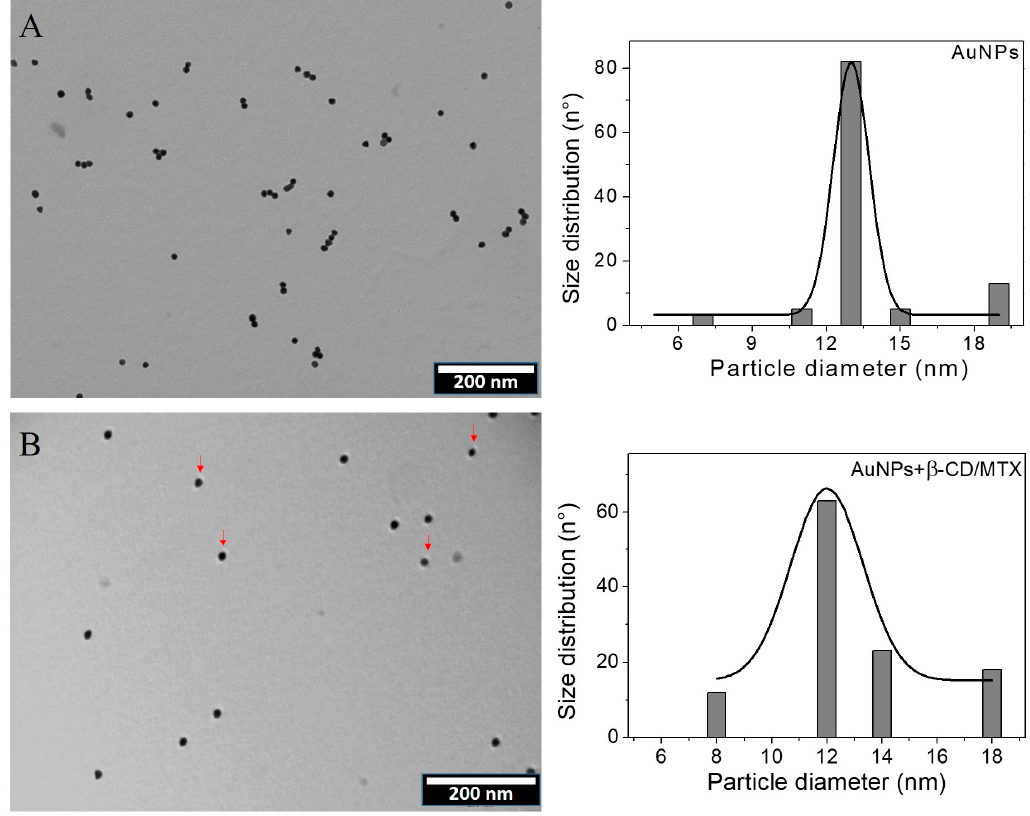
Figure 4. TEM micrographs and size histograms of AuNPs stabilized with citrate ( A ) and β -CD/MTX ( B ). The red arrows indicate the presence of an organic stained layer present around several gold spheres, which could correspond to the IC.